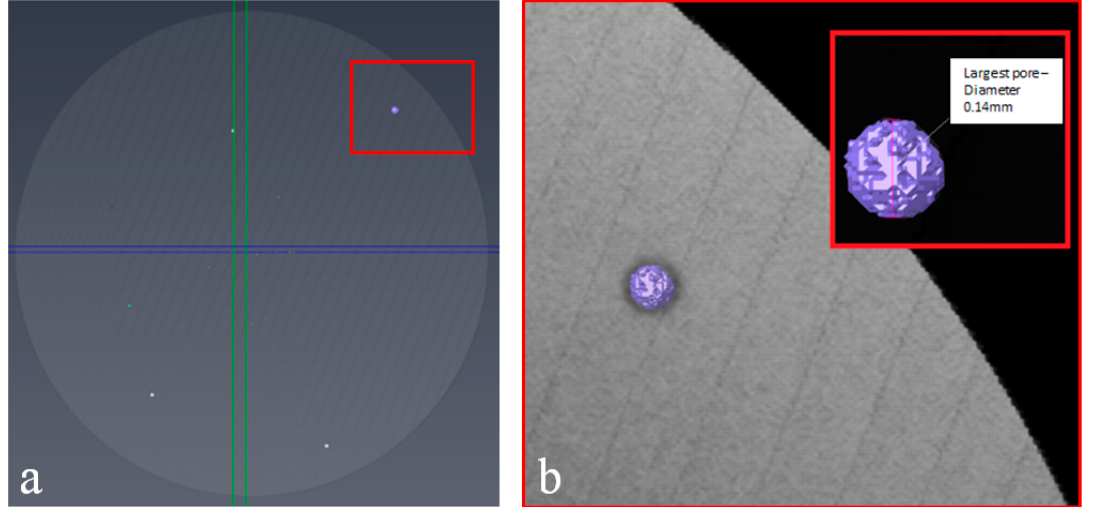
Figure 7. Images of ( a ) 3D volume render and ( b ) the largest porosity feature in the EBM disc using VG studio. Table 3. Porosity measurements of Ti-6Al-4V variants (minimum voxel size of 6.7 μ m).